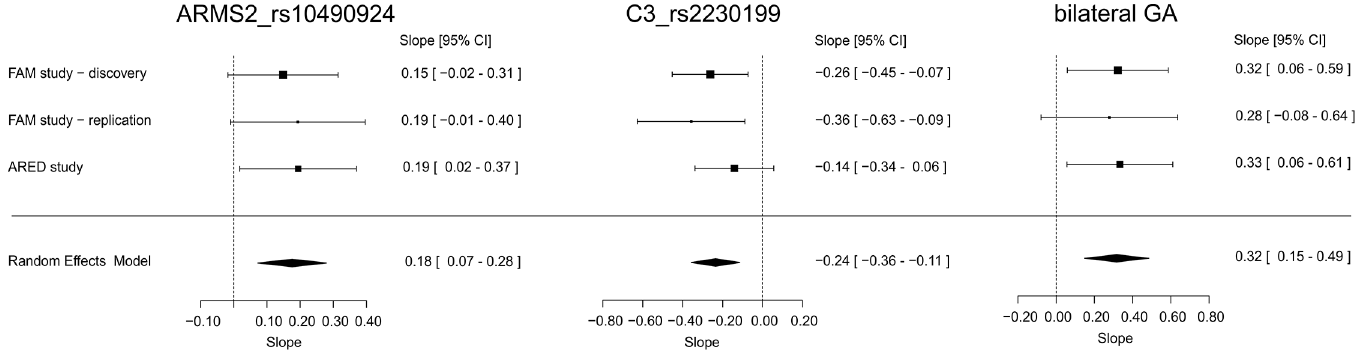
Fig 1. Forestplot representations of univariate linear regression models. Univariate linear regression models were fitted for variables ARMS2_rs10490924, C3_rs2230199 and bilateral GA for each study separately. Slope and standard errors obtained from the models of each study were combined by performing a meta-analysis assuming a random effects model. The combined estimates for slope and 95% confidence intervals (CI) were computed from the random effects model. In all analyses, no evidence was found for heterogeneity (P heterogeneity > 0.05).